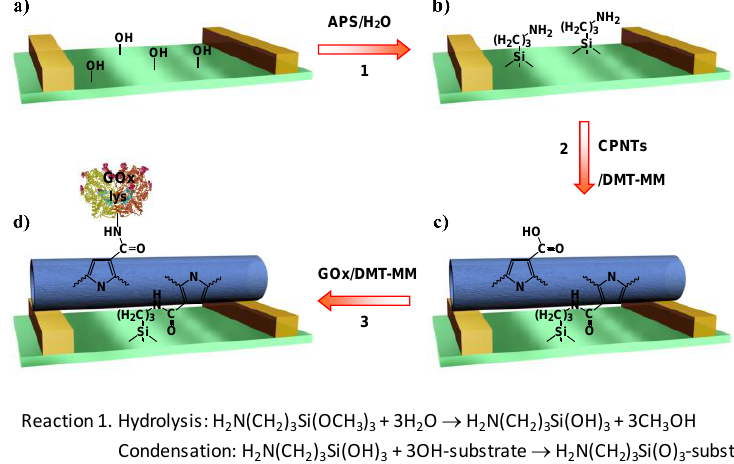
Figure 17. Schematic illustration of the reaction steps for the fabrication of a field-effect transistor (FET) sensor platform based on carboxylated PPy nanotubes (CPNTs): ( a ) microelectrode substrate; ( b ) aminosilane-treated substrate; ( c ) immobilization of the nanotubes onto a substrate; and ( d ) binding of GO x to the nanotubes. Reprinted with permission from [154]. Copyright 2008, American Chemical Society.